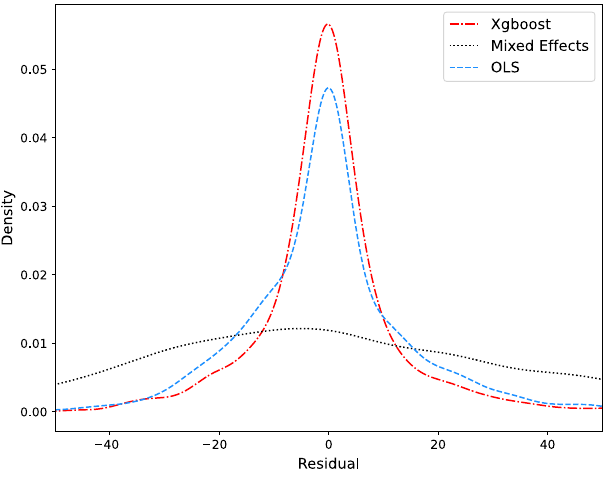
FIG. 6. Residual distributions for the LASSO study.